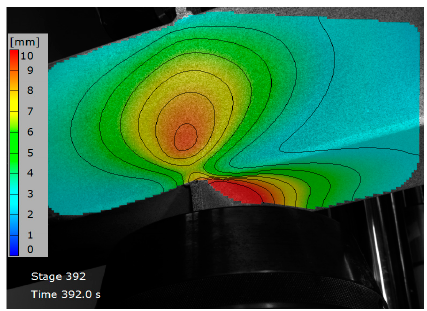
Figure 6. Sample of displacements map.